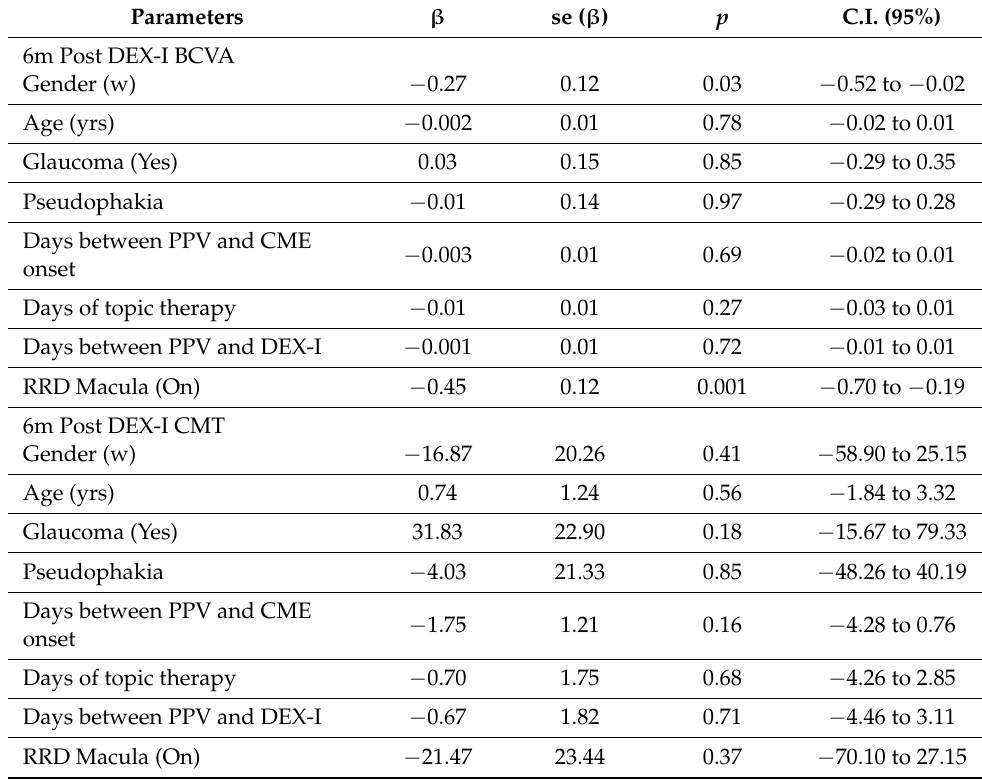
Table 3. Univariate regression models of BCVA and OCT at 6 months after DEX-I, on demographic and clinical parameters.